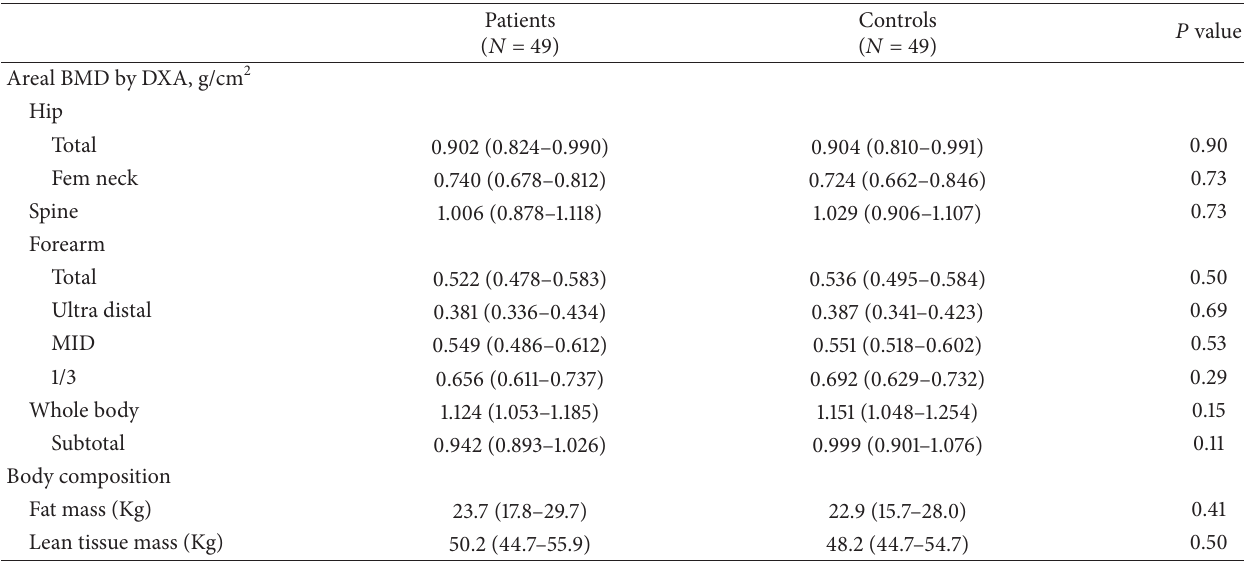
Table 4: Bone indices as measured by DXA scans in patients on long-term treatment with levothyroxine and matched controls. Median with interquartile (25%–75% percentiles)